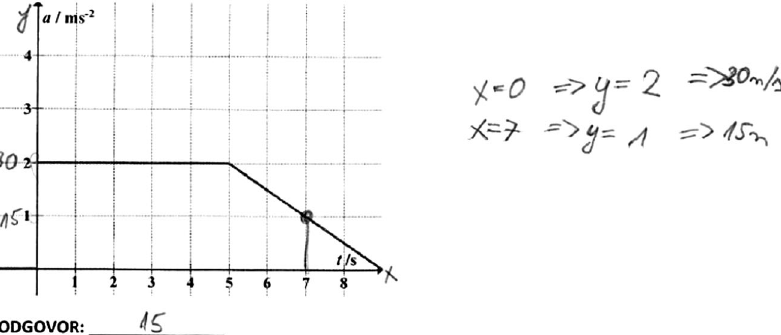
FIG. 5. An example of student answer to question CA3, where student fitted a scale of velocities on the graph of acceleration vs time, and determined the velocity at t ¼ 7 s as 15 m = s from the initial velocity of 30 m =